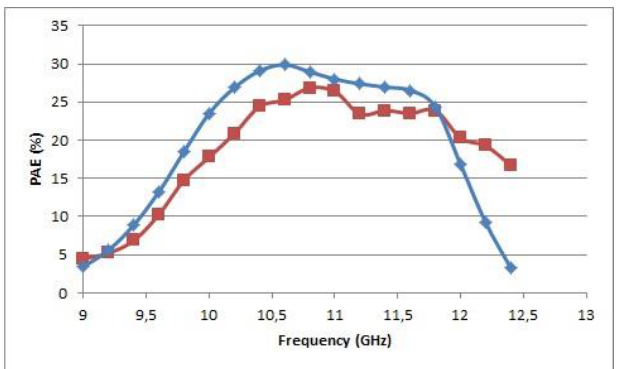
Figure 16: Power added efficiency for amplifier operating between 10-12 GHz. Blue line: simulation, red line: measurement Table 1: Comparison with other state of the art Rf.